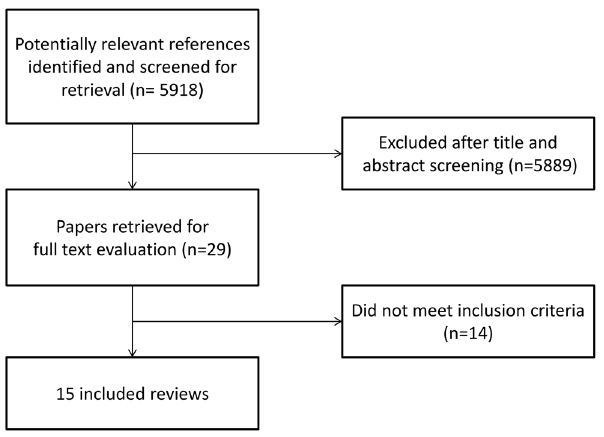
Figure 1. Search strategy results and description of studies selection